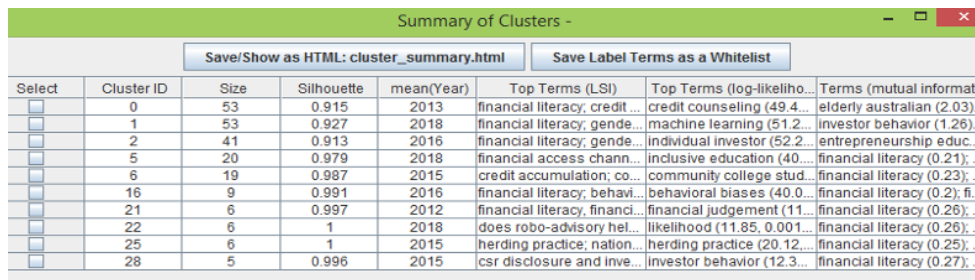
Figure 4. A summary table of ten clusters according to silhouette value prepared using CiteSpace